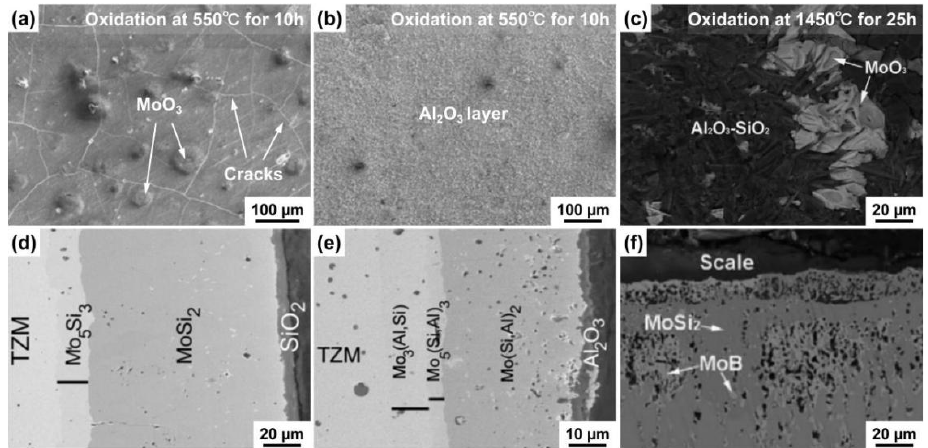
Figure 4. Surface and cross-section images of HAPC coatings at different Oxidation conditions; ( a , d ) MoSi 2 coating, ( b , e ) Mo(Si, Al) 2 coating. Reprinted with permission from [39]; Reproduced from (Paul et al., 2014). ( c , f ) Mo(Si,Al) 2 -MoB coating. Reprinted with permission from [38]; Reproduced from (Chakraborty et al., 2008).